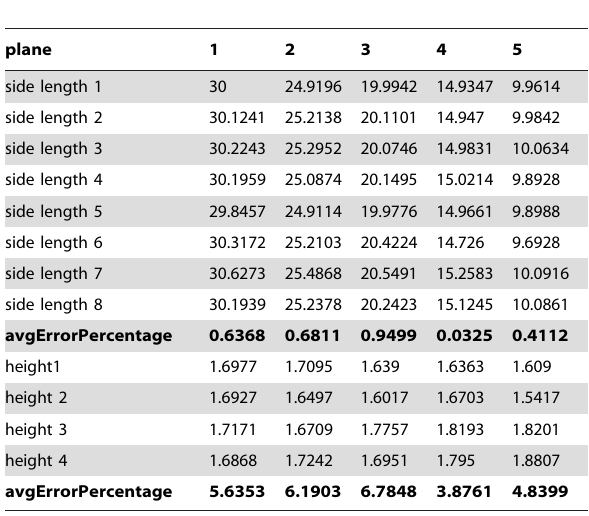
Table 2. Distance measurements of the reconstructed pyramid.